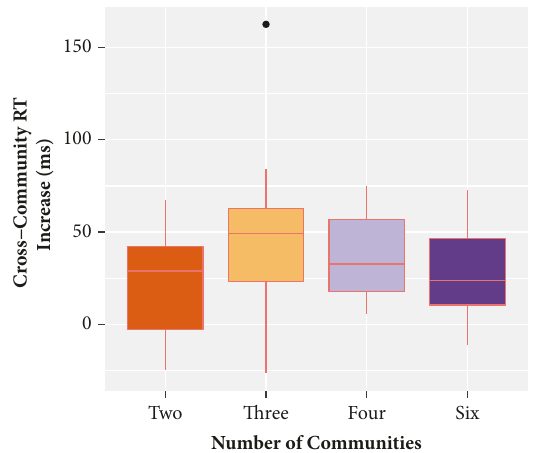
Figure 2: Boxplots ( N = 80 participants) illustrating the increase in reaction time across community boundaries for each graph type (2, 3, 4, or 6 communities). Values used to create this plot were calculated by subtracting, for each participant, average RT for nodes prior to entry into a new community from average RT for nodes representing entry into a new community. A value of 0 ms would indicate no difference in reaction time at an inter-community